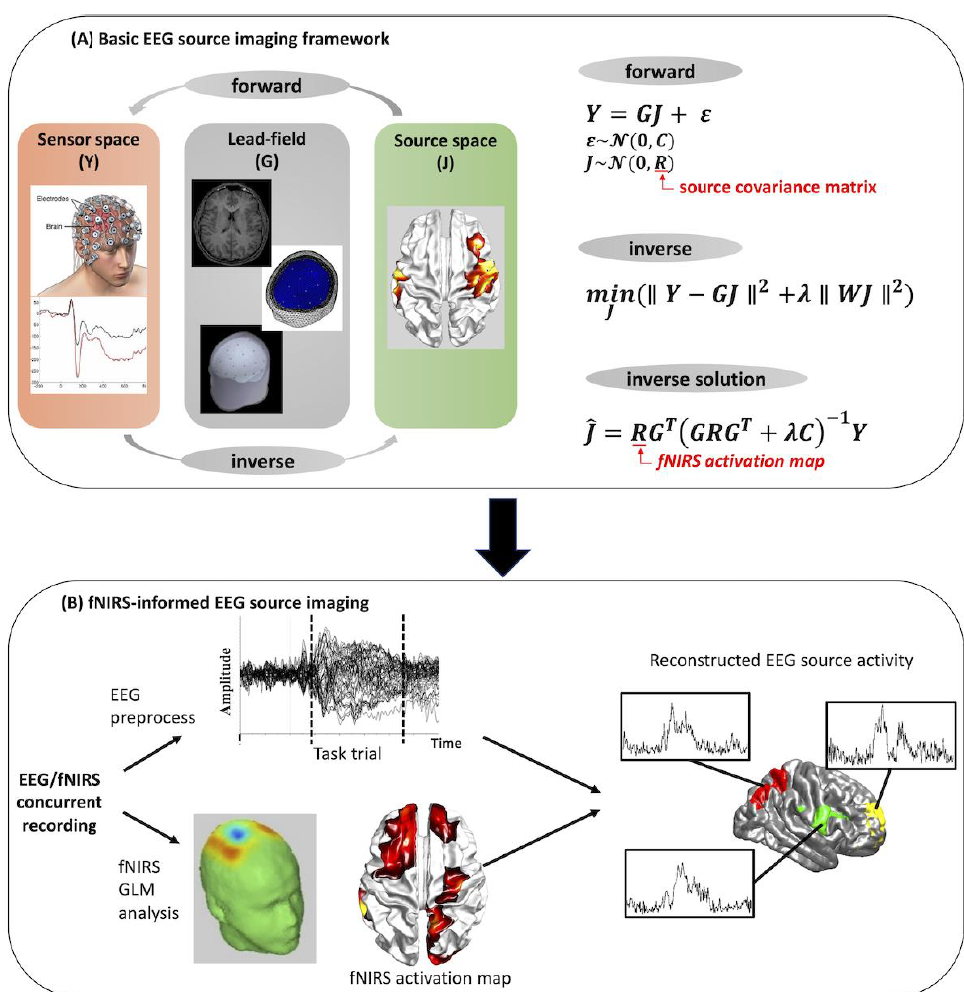
Figure 8. Basic concepts of EEG source imaging and traditional pipeline of fNIRS-informed EEG source imaging analysis (adapted with permission from Ref. [27]. 2019, Li et al.